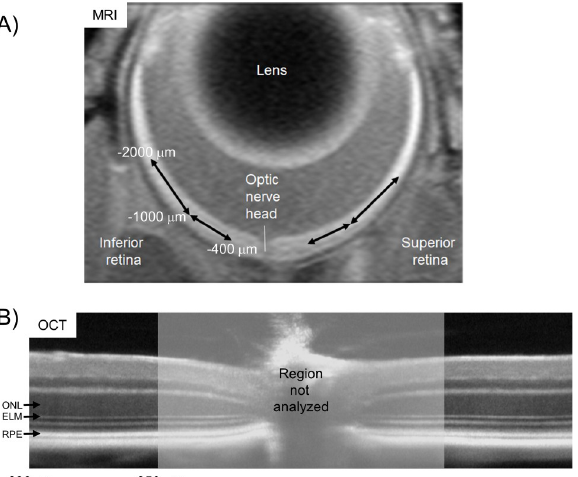
Fig 1. Comparison of MRI and OCT regions-of-interest (ROI’s). Four non-overlapping retinal regions were evaluated from MRI data A): ± 400–1000 μ m and ± 1000–2000 μ m from the optic nerve head for their transretinal 1/ T1 profiles (shown in Figs 3 and 6). Two regions in central retina were studied from OCT data B): ± 350–630 μ m from the optic nerve head to determine outer nuclear layer (ONL) thickness, and the external limiting membrane–retinal pigment epithelium (ELM-RPE)